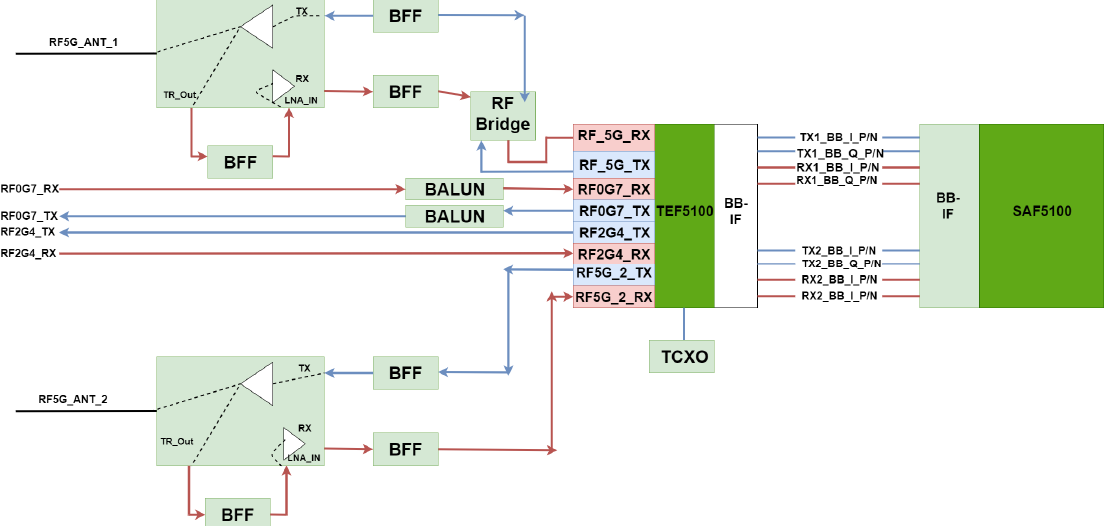
Figure 8. Front-End RF block diagram.